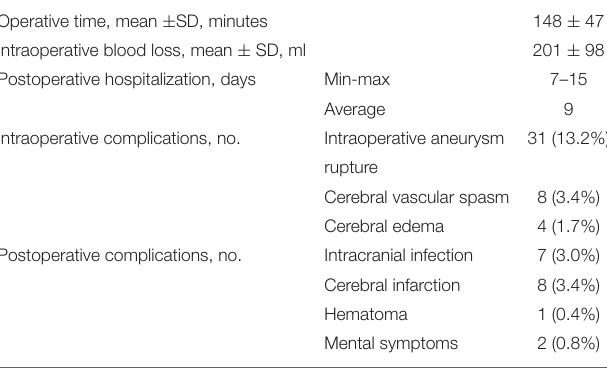
TABLE 2 | Surgery-related details, intraoperative and postoperative complications.